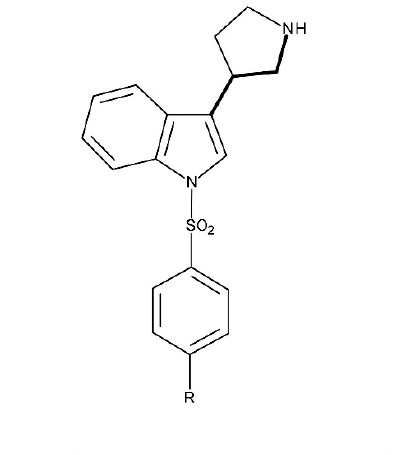
Figure 2. Chemical structures of sumatriptan and its analog.